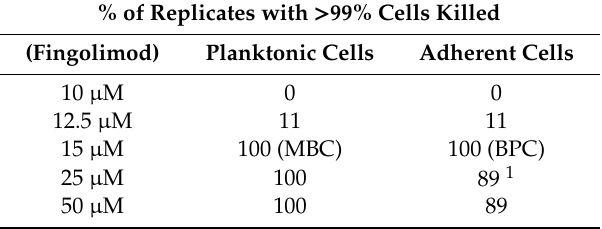
Table 2. MBC and BPC confirmation of fingolimod against S. aureus after a pre-exposure treatment. Results are expressed as the percentage of replicates for which > 99% of cells were killed (one or less colony counted) ( n = 9, three separate assays with each three